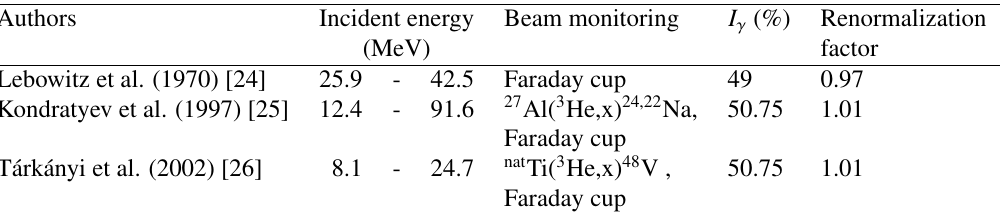
Figure 1. Excitation function for the nat Cu( 3 He,x) 65 Zn reaction. The excitation functions in the literature are corrected for the renormal- ization factor in Table 2. The TENDL-2019 and EMPIRE-3.2.3 excitation function curves include the contribution of nat Cu( 3 He,x) 65 Ga reaction. Table 2. Measured nat Cu( 3 He,x) 65 Zn excitation functions in the literature. All works use the 1115 keV γ -line and I γ is the intensity adopted in each work. In Fig. 1, the cross-sections in the literature are multiplied by the renormalization factor which is the ratio of the I γ value adopted by the authors to the I γ value adopted by us ( = 50.04%). Lebowitz and Greene (1970) reported isotopic cross-sections for 65 Cu( 3 He,x) 65 Zn reaction from a measurement with a natural sample, and their data renormalized to the natural abundance are plotted in Fig.